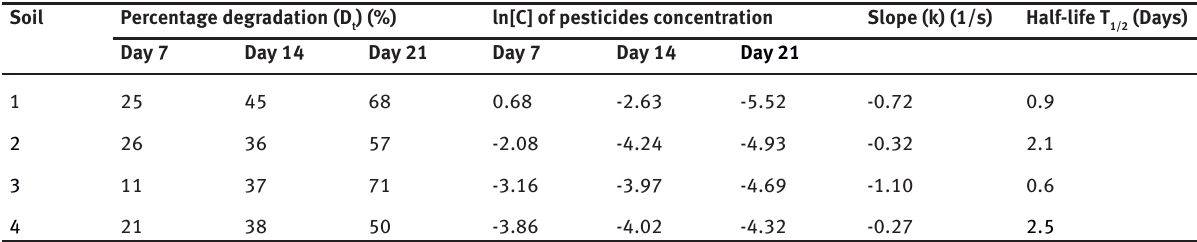
Table 3: Biodegradation of Bensulfuron-methyl by Penicillium chrysogenum . Soil Percentage degradation (D